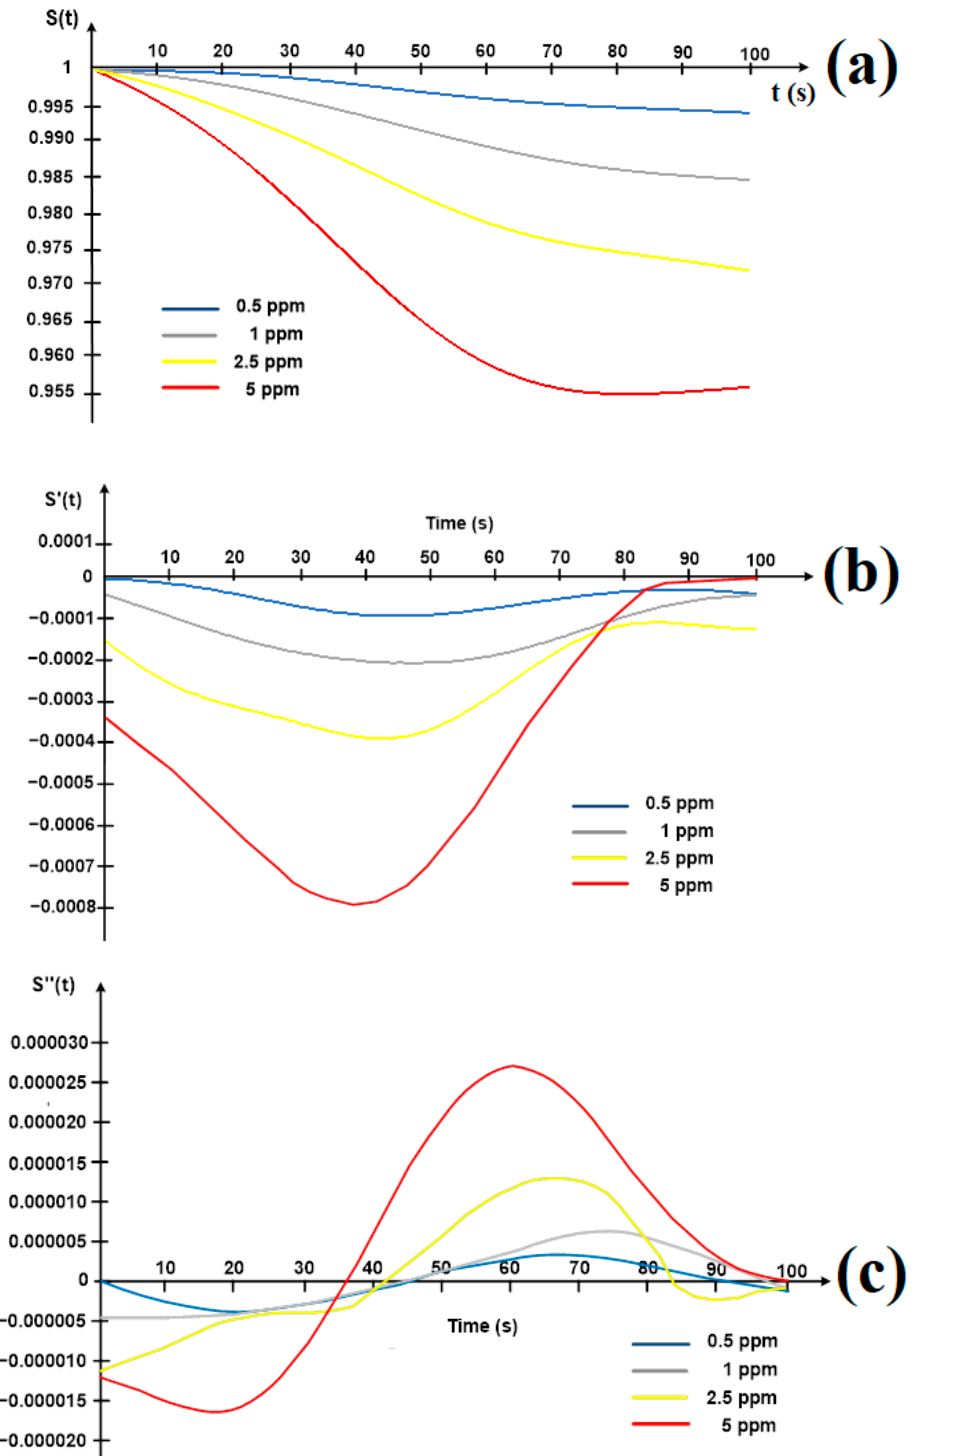
Figure 5. The kinetics ( a ) of the Type 2 gas sensor response S ( t ); ( b ) of the first derivative S ( t ); ( c ) of the second derivative S ( t ) at different NO 2 concentrations.